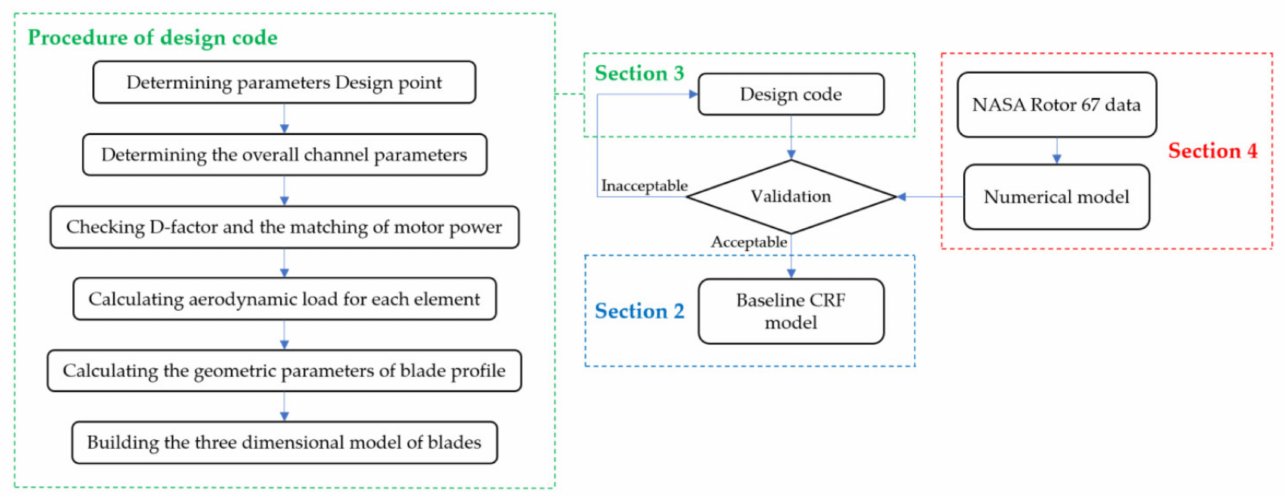
Figure 1. Flowchart of the article structure and related design code procedure.